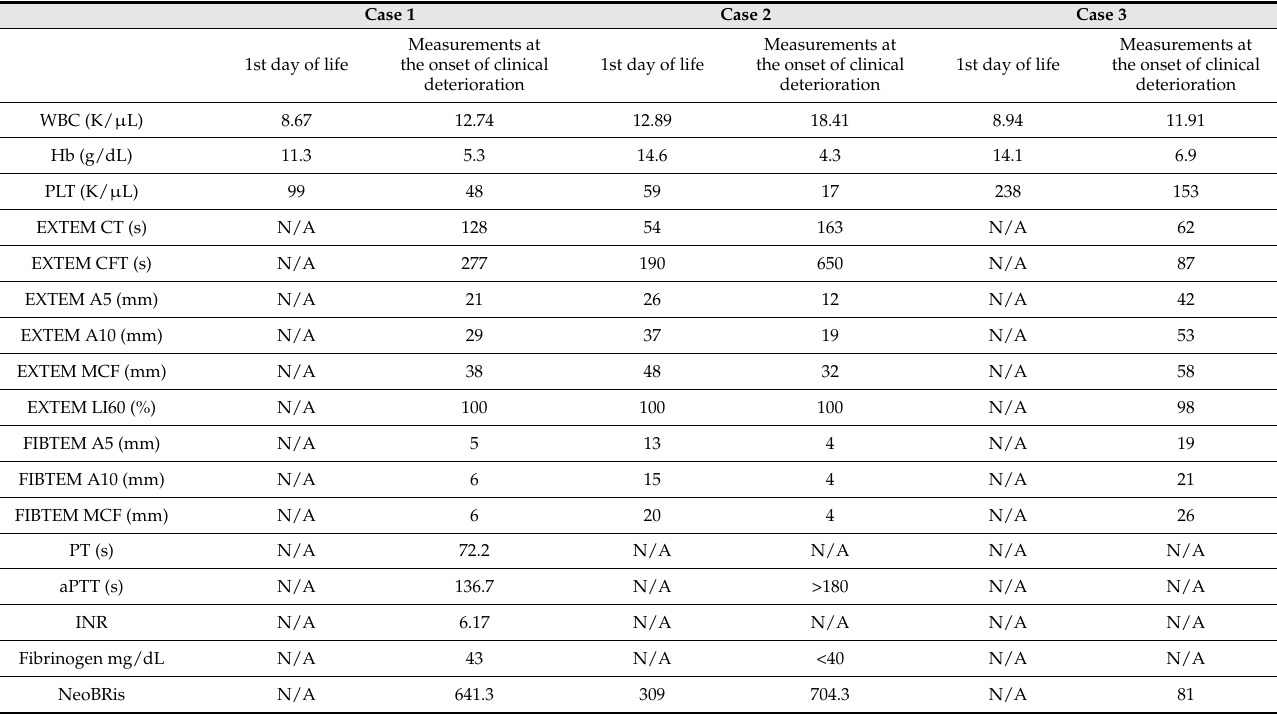
Figure 2. Abdominal ultrasonography depicting a cystic formation 2.1 cm × 0.5 cm in the anterior portion of the right liver, with anechoic characteristics (blue arrow).